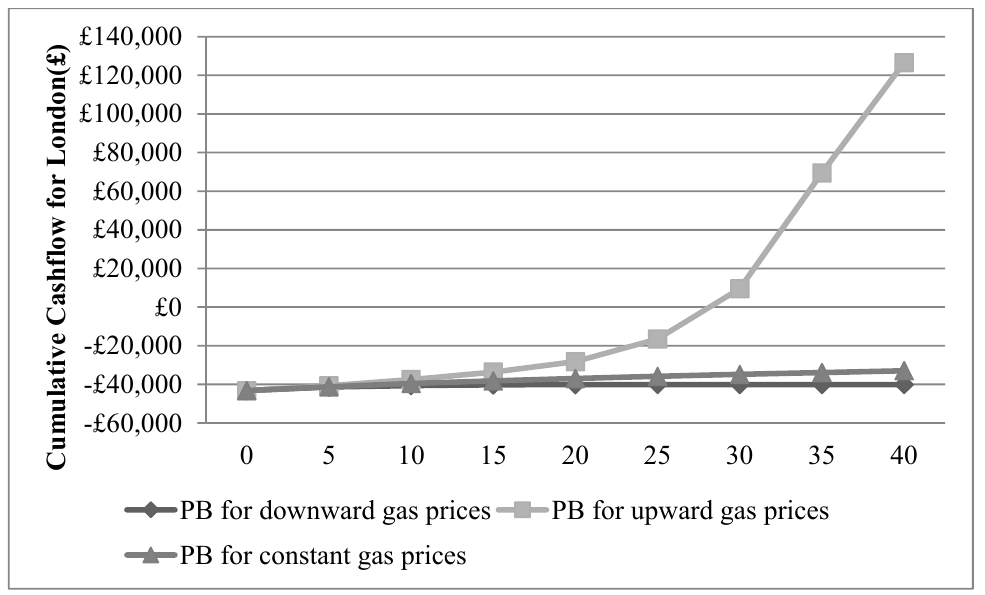
Figure 17. Cumulative cash flow of the refurbished house for current and future London weather data over 40 years for different gas price trends.